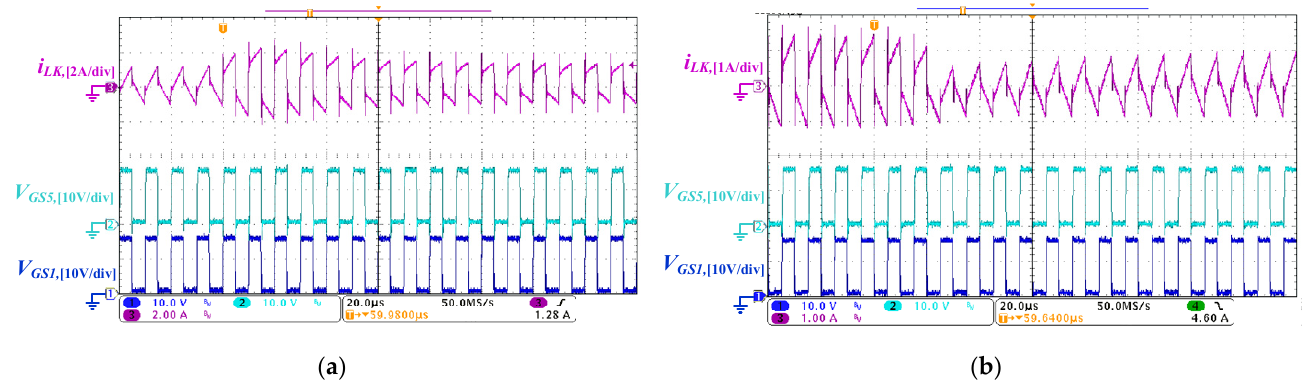
Figure 22. Waveforms of mode switching (in forward power conversion): ( a ) load change from 150 W to 300 W; ( b ) load change from 300 W to 150 W.